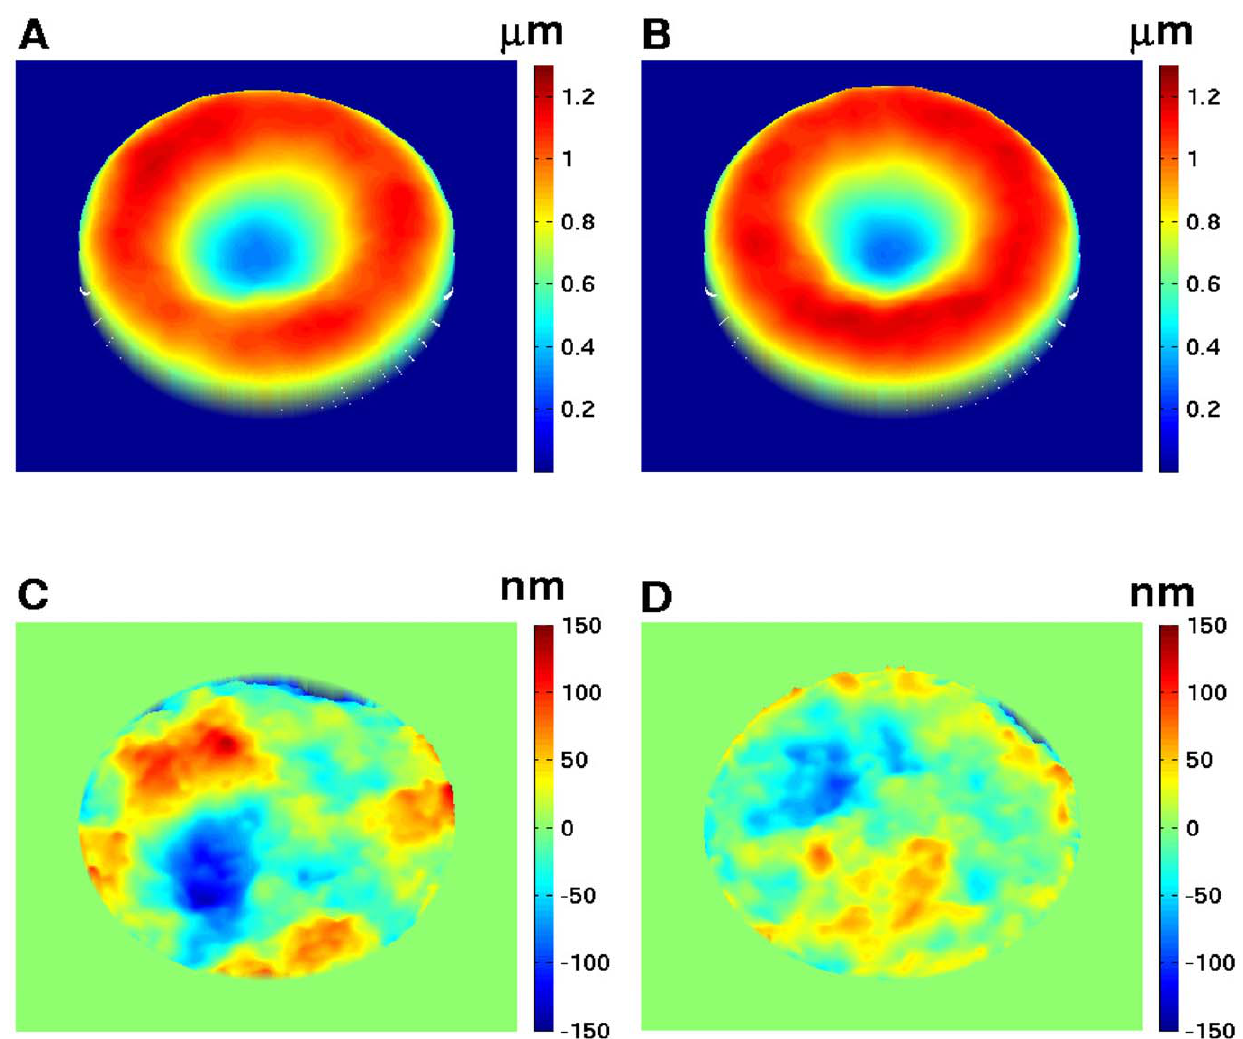
Figure 4. Instantaneous height and fluctuations of healthy RBC (A and C) and Pf-RBC in trophozoite stage (B and D) at T ~ 23 o C . A RBC is attached to a solid surface by fixing 0 : 13 fraction of vertices on the RBC bottom. The instant fluctuation map is obtained by subtracting time- averaged cell shape from the instantaneous height map. Zero value in A and B corresponds to the half height of RBC. The shear moduli of Pf-RBCs for different stages are given in Table 1. The bending stiffness and the membrane viscosity in all cases are set to 2 : 4 | 10 { 19 J and 0 : 022 Pa : s , respectively. Figure 6 (right) presents dependence of the FWHM values on the membrane bending rigidity and the shear modulus normalized by their healthy RBC values k c ~ 2 : 4 | 10 { 19 J and ~ 6 : 3 m N = m . Here and further, the FWHM values in m 0 simulations are averaged over a RBC surface area of radius 3 m m from the cell center. Both membrane properties strongly affect the values of fluctuations with a common trend: the stiffer the RBC, the smaller the fluctuation amplitudes characterized by FWHM values.